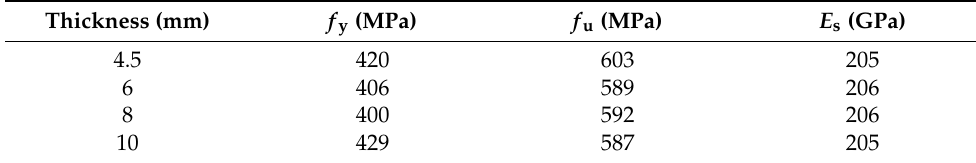
Figure 1. Test setup and stress-strain curves of steel tensile coupons. ( a ) Tensile coupon test setup; ( b ) stress-strain curves of steel tensile coupons. Table 2. Material properties of steel tubes.